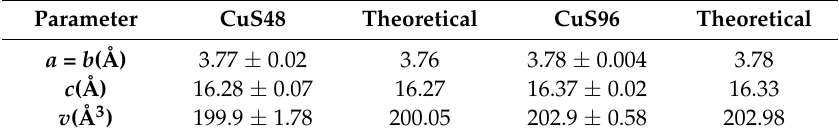
Table 2. Cell parameters of samples CuS48 and CuS96 compared to the ICDD database [01-075-2233].